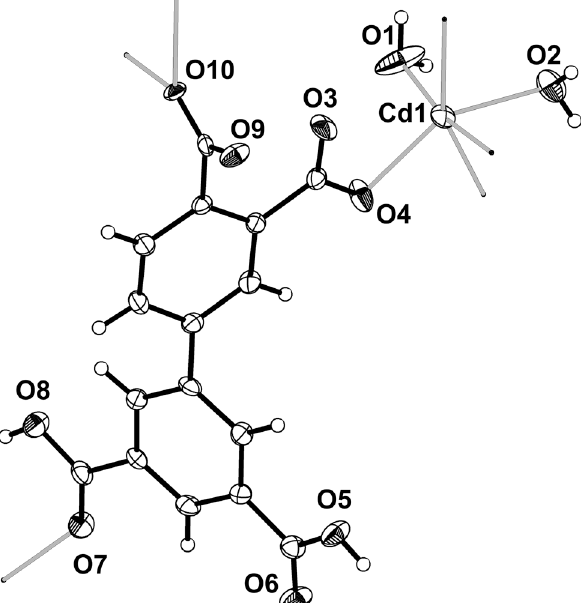
Table 1 contains crystallographic data and Table 2 contains the list of the atoms including atomic coordinates and displacement parameters.